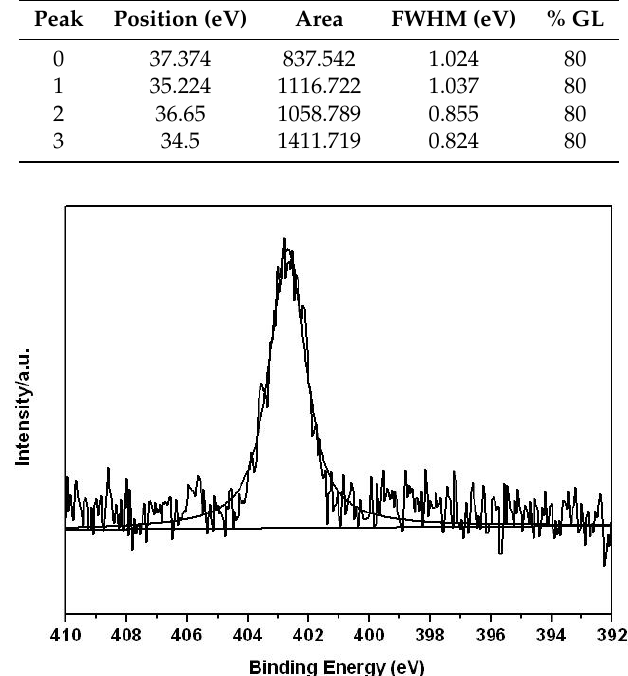
Figure 5. XPS spectrum of the N 1s region for the catalyst.